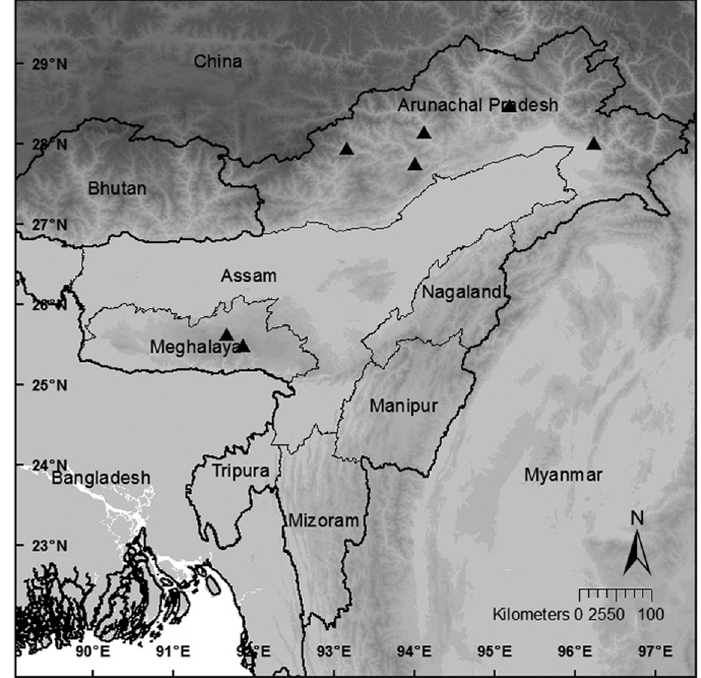
Fig. 25. Map showing the location of B. griffithiana (A.DC.) Warb. specimens.